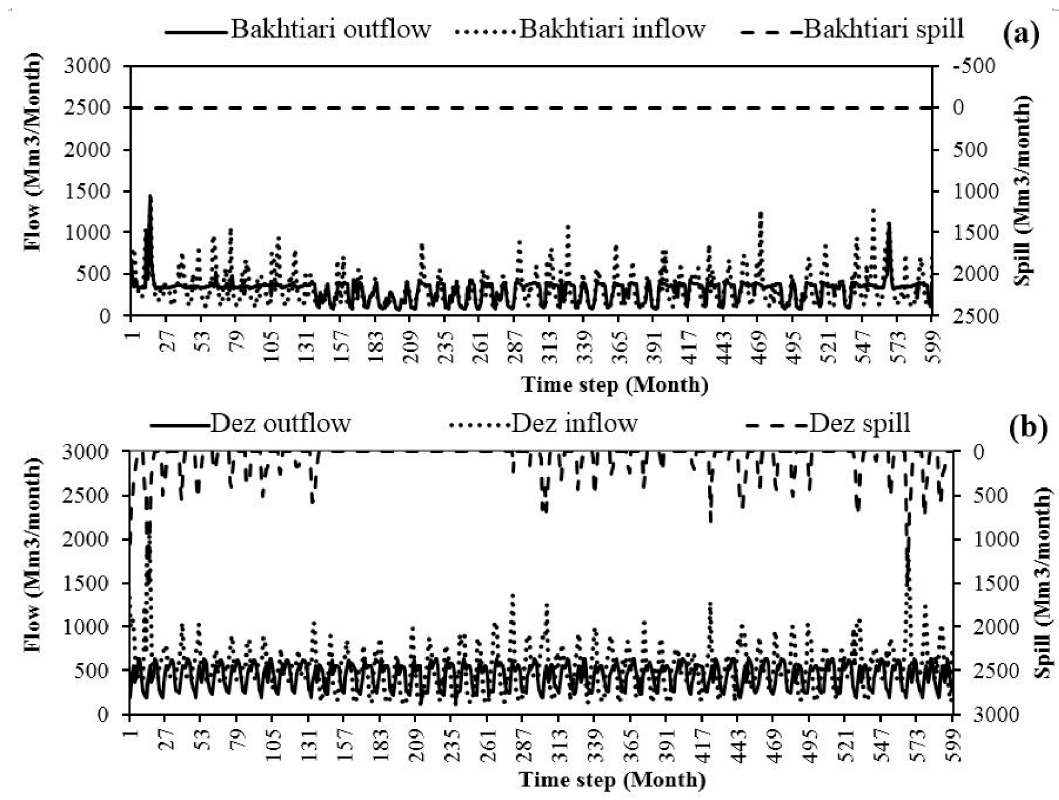
Figure 12. The monthly inflows, outflows, spills, and reservoir storages for the 2080s future time horizon based on the projections of the IPSL under the B1 scenario; ( a ): inflow, outflow, and spill of the Bakhtiari reservoir; ( b ): inflow, outflow, and spill of the Dez reservoir.